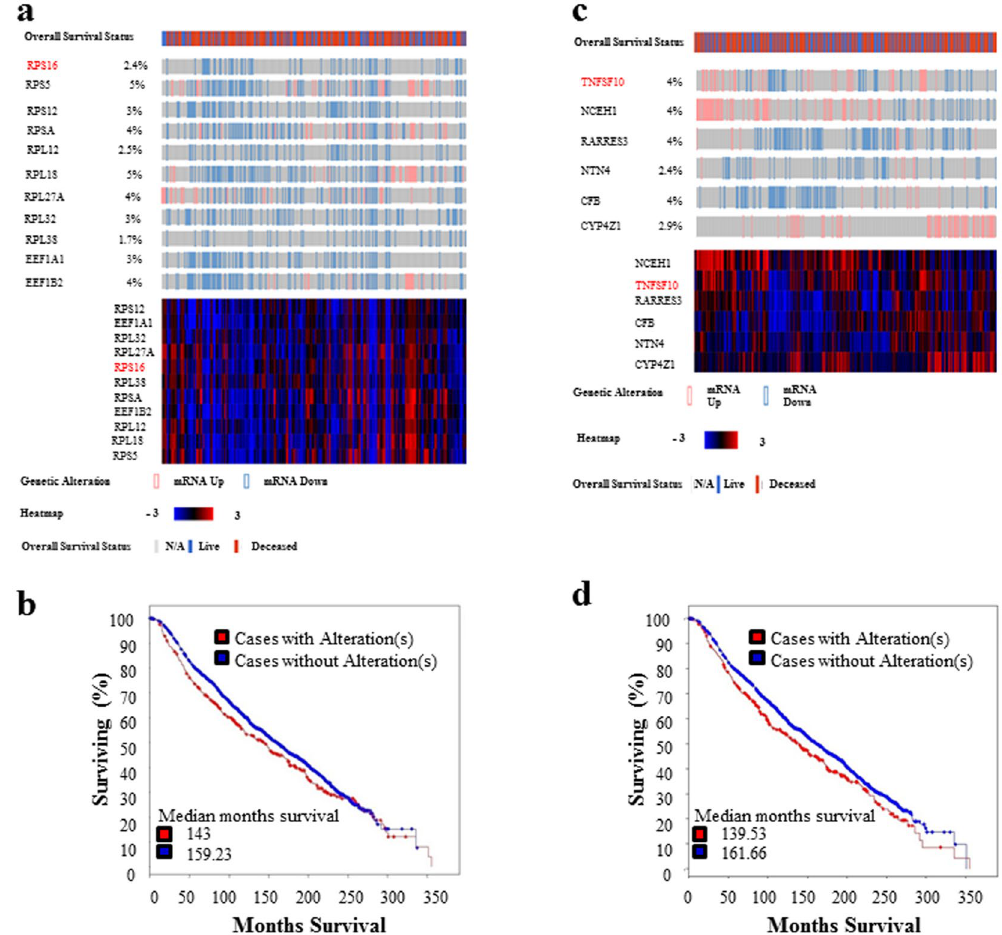
Figure 7. Alternations of RPS16 and TNFSF10 along with their mutually co-expressed genes might correlate the survival status in breast cancer patients. ( a ) Oncoprint of RPS16 and its mutually co-expressed 10 genes ( RPS5 , RPS12 , RPSA , RPL12 , RPL18 , RPL27A , RPL32 , RPL38 , EEF1A1 and EEF1B2 ) in breast cancer patients, overall survival status of the patients is shown at the top bar, while heatmap (bottom) presenting the overall expression profile of the genes. ( b ) Survival graph showing that alterations in the expression of RPS16 and its mutually co-expressed 10 genes are negatively correlated with the survival status of breast cancer patients. ( c ) Oncoprint of TNFSF10 and its five mutually co-expressed genes ( NCEH1 , RARRES3 , NTN4 , CFB and CYP4Z1 ) in clinical breast cancer patients. Overall survival status of the patients is shown at the top, while heatmap at the bottom presenting the overall expression profile of the genes. ( d ) Survival graph showing that alterations of TNFSF10, NCEH1 , RARRES3 , NTN4 , CFB and CYP4Z1 are negatively correlated with the overall survival status of breast cancer patients. The data were generated by the TCGA Research Network: http://